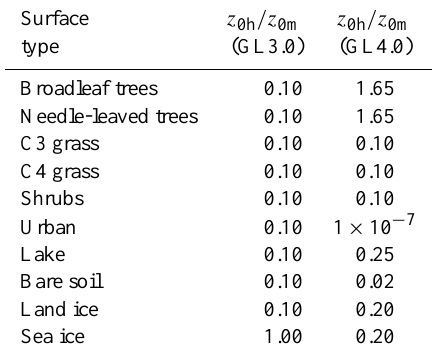
Table 3. Changes to the ratio of the thermal to the momentum roughness lengths ( z 0h /z 0m ) for each surface type between GL3.0 and GL4.0.